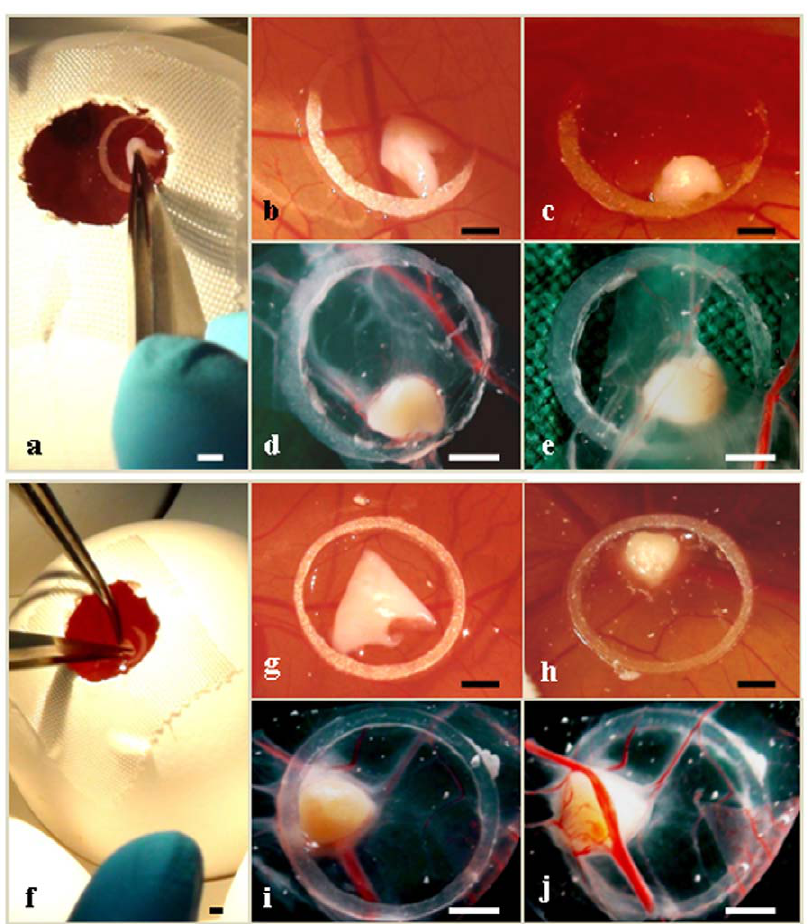
Figure 2. Cryopreserved ovarian medulla-free and medulla-containing pieces before and after 5 days culture with chorioallantoic membrane (CAM) system. (a, b, c, d, e) medulla-free piece, (a, b) just after thawing and seeding on CAM marked by silicone ring, (c, d, e) the same piece after culture, (c) piece on CAM, (d, e) piece in Petri dish; (f, g, h, i, j) medulla-containing piece, (f, g) just after thawing and seeding on CAM marked by silicone ring, (h, i, j) the same piece after culture, (c) piece on CAM, (d, e) piece in Petri dish; (e) outer CAM-layer with medulla-free piece, (j) inner CAM-layer with medulla-containing piece. Different intensiveness of the avian vascularisation in the place of the seeding of pieces was noted: (e) versus (j). Bar=1 mm.